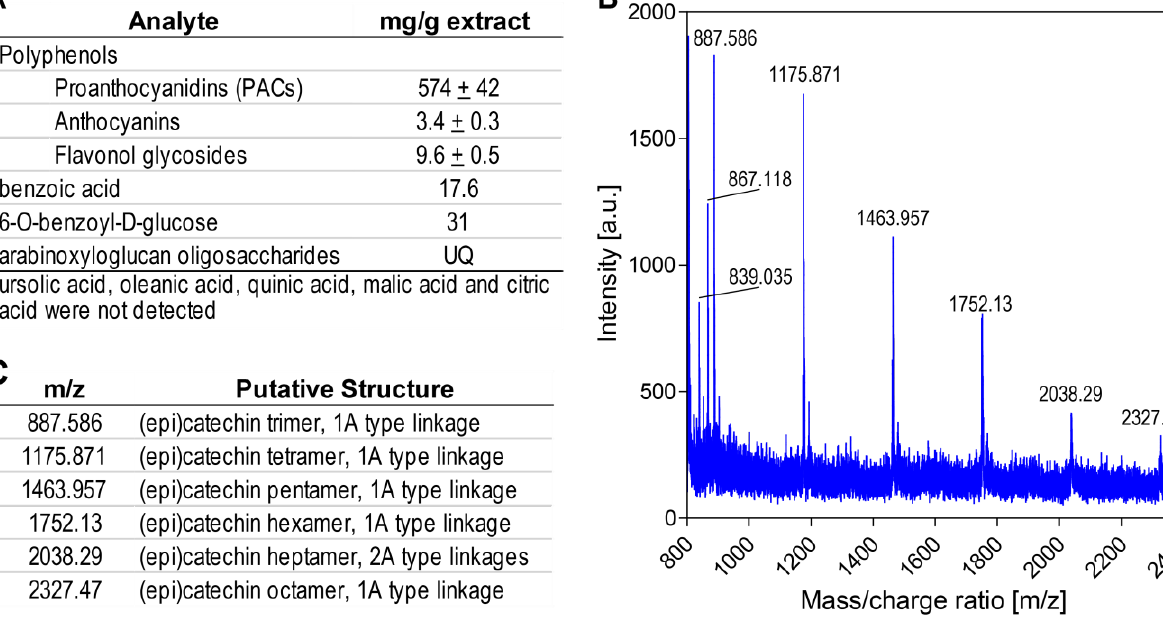
FIGURE 1: Cranberry juice extract composition. (A) Summary of cranberry juice extract components. UQ=Detected in unknown quantity. (B) MALDI-TOF MS spectrum of proanthocyanidin (PAC) fraction from cranberry juice extract, in positive ion mode. (C) Putative identification of the major ion masses in the PAC